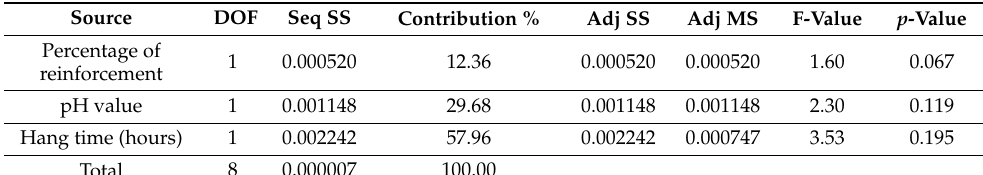
Table 17. Outline of ANOVA analysis (corrosion test).